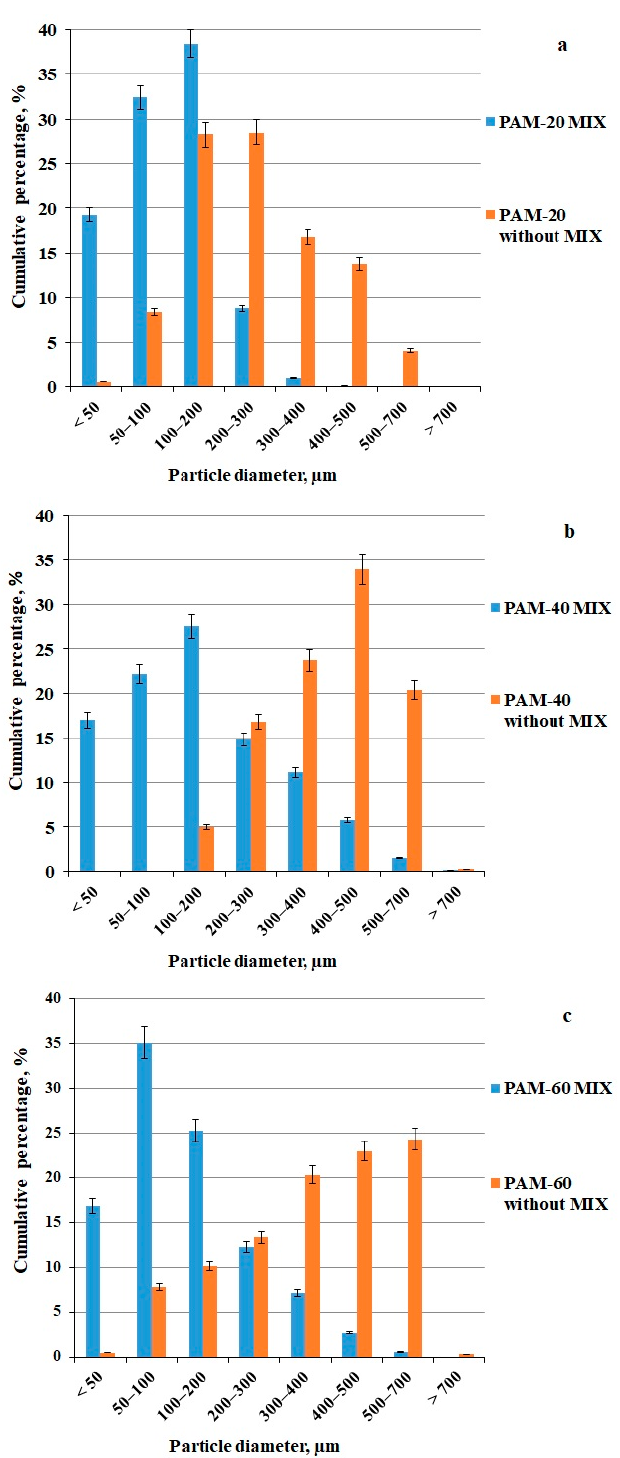
Figure 4. Floccules size in the samples treated with 20 ( a ), 40 ( b ), and 60 ( c ) mg polyacrylamide (PAM)/g total solids (TS) and incubated with and without mixing, at the end of the experiment. In mixing mixtures, floccules break-up was more rapid, and by the end of the experi- ment 39.2–51.9% were smaller than 100 µ